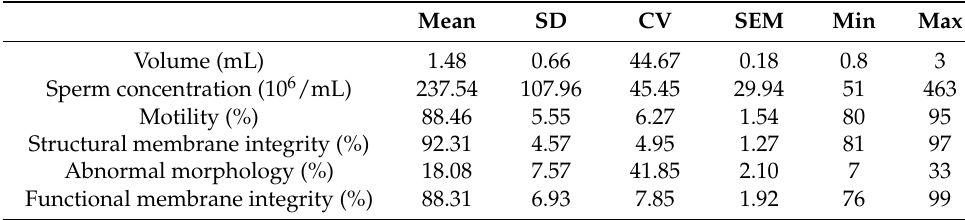
Table 1. Semen parameters of raw canine semen ( n = 12).